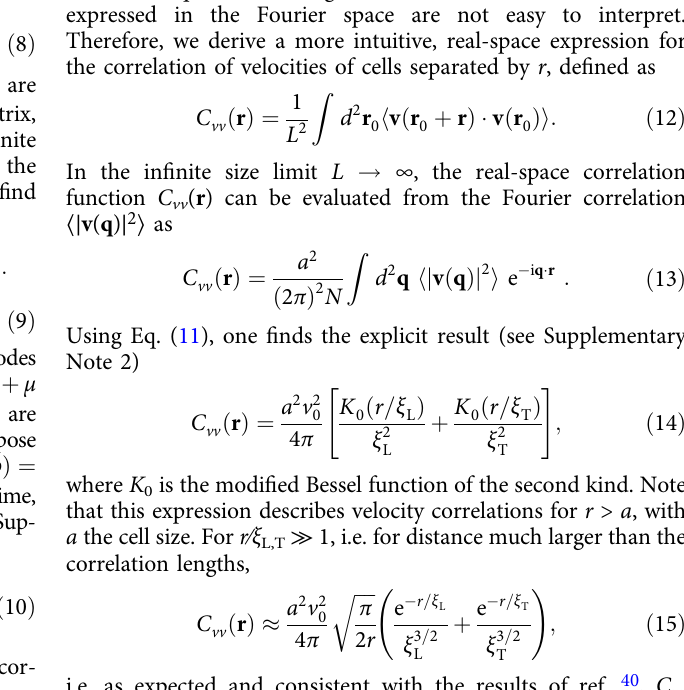
Fig. 2 Glassy dynamics. Alpha-relaxation time τ α as a function of the persistence time τ and effective temperature T log τ α . a Soft disk model at ϕ = 1, the leftmost column is for a thermal system at T = T eff . b SPV model at (cid:2) p 0 ¼ 3 : 6 (see